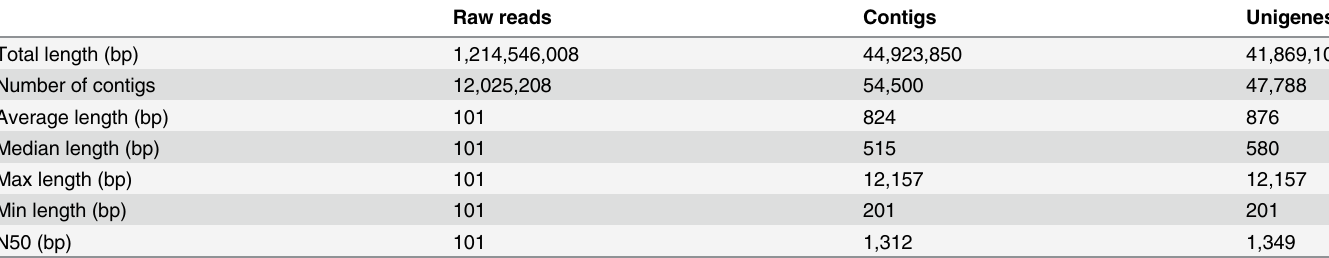
Table 1. Summary of the sequence assembly after Illumina sequencing in red